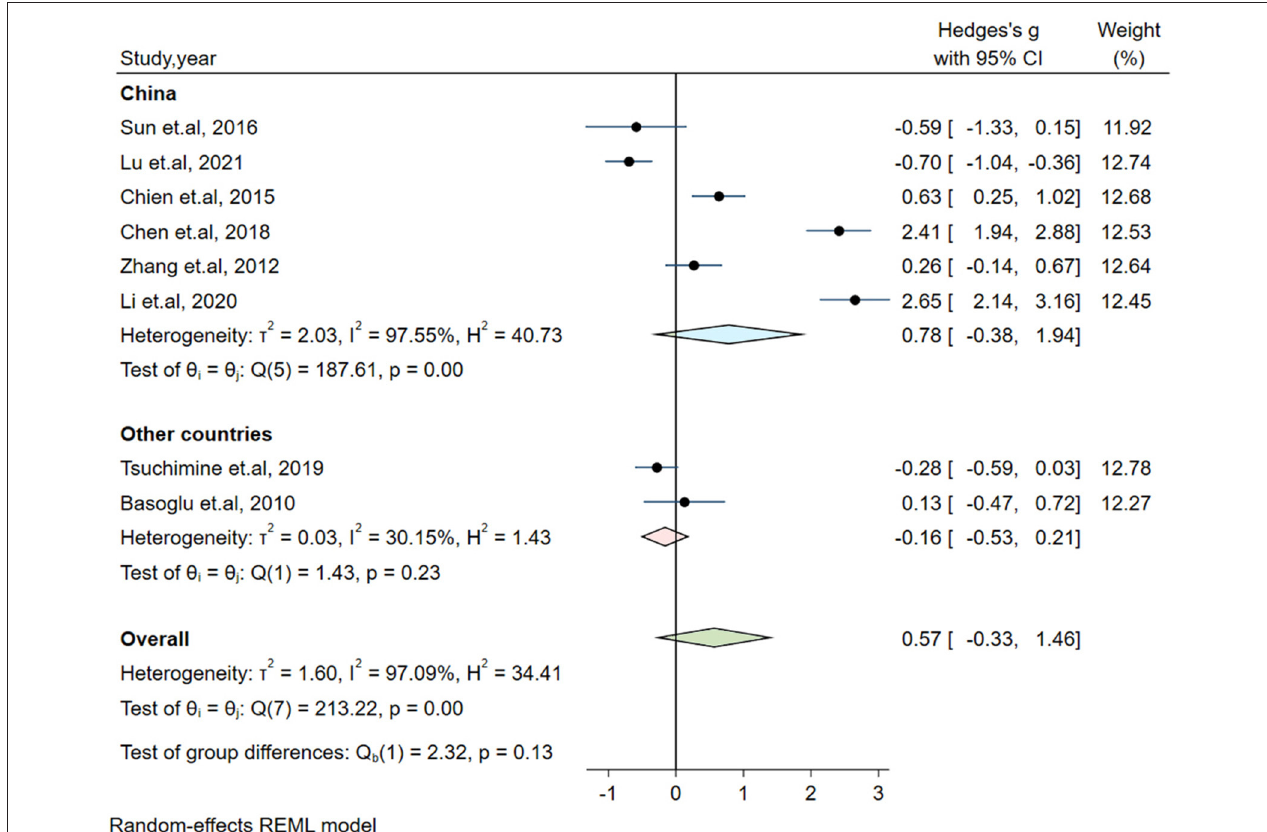
FIGURE 4 | Subgroup analysis of plasma orexin-A levels in patients with schizophrenia compared to healthy controls (based on country).